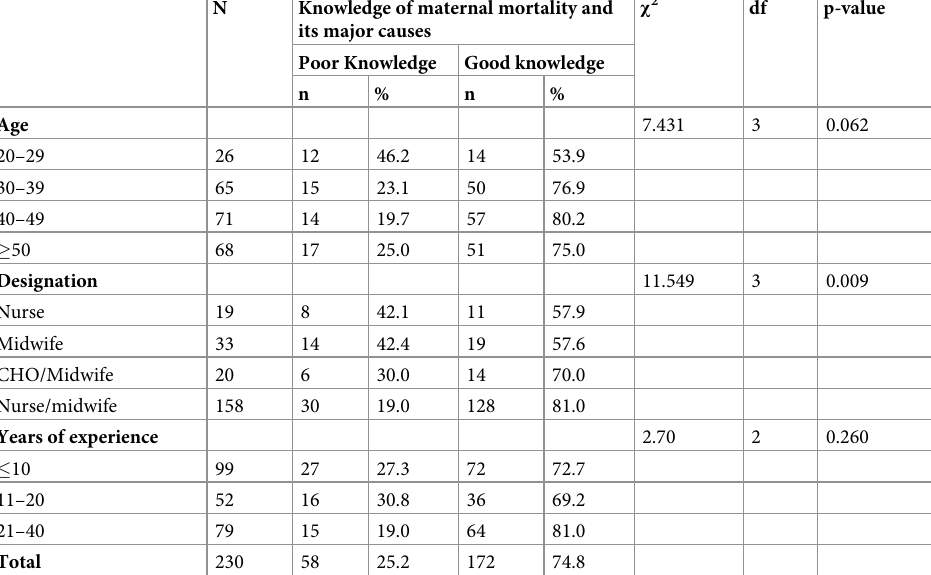
Table 4. Association between respondents’ age, qualification and work experience and knowledge of maternal mortality and its major causes. N